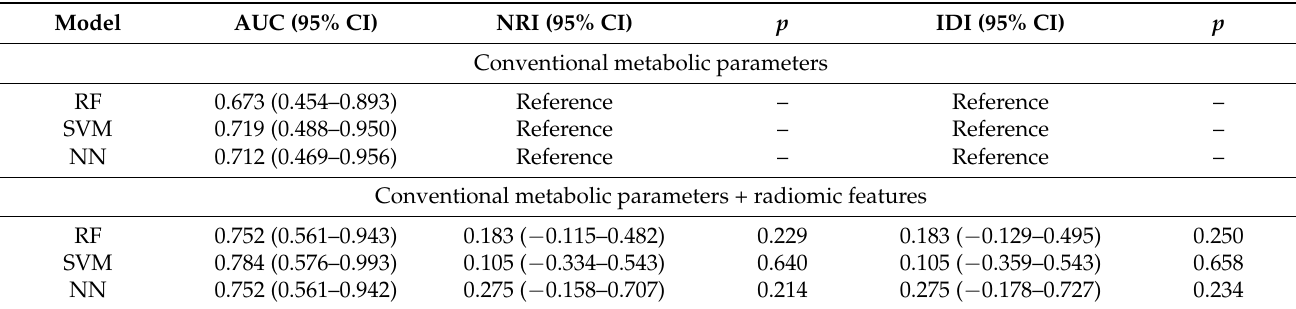
Figure 2. Receiver operating characteristic curves of the prediction models constructed by the random forest, support vector machine, and neural network algorithms using conventional metabolic parameters only ( A ) and conventional metabolic parameters + radiomic features ( B ) in the test dataset. Table 4. Performance metrics of prediction models for predicting tumor budding status in the test